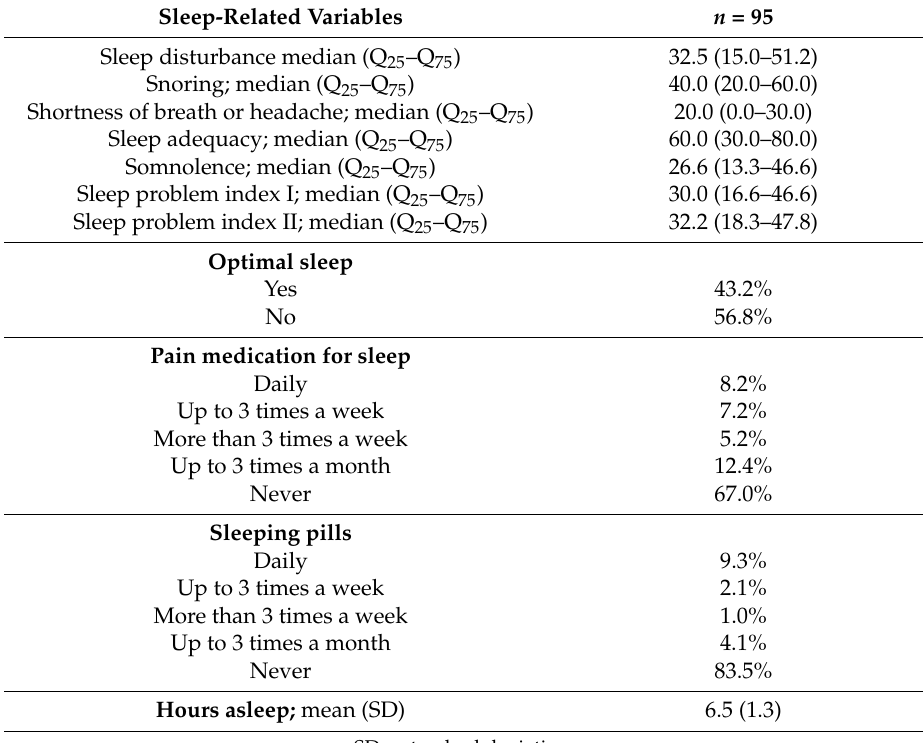
Table 2. Sleep characteristics of the study participants.